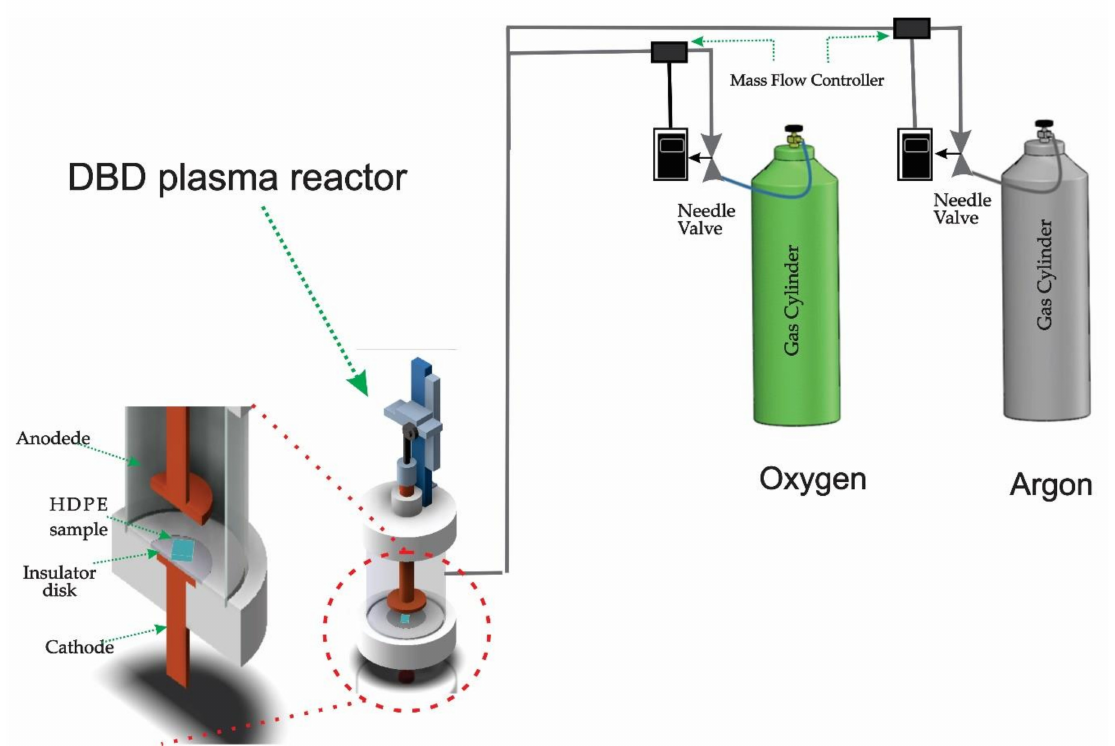
Figure 1. Dielectric barrier discharge (DBD) plasma reactor.